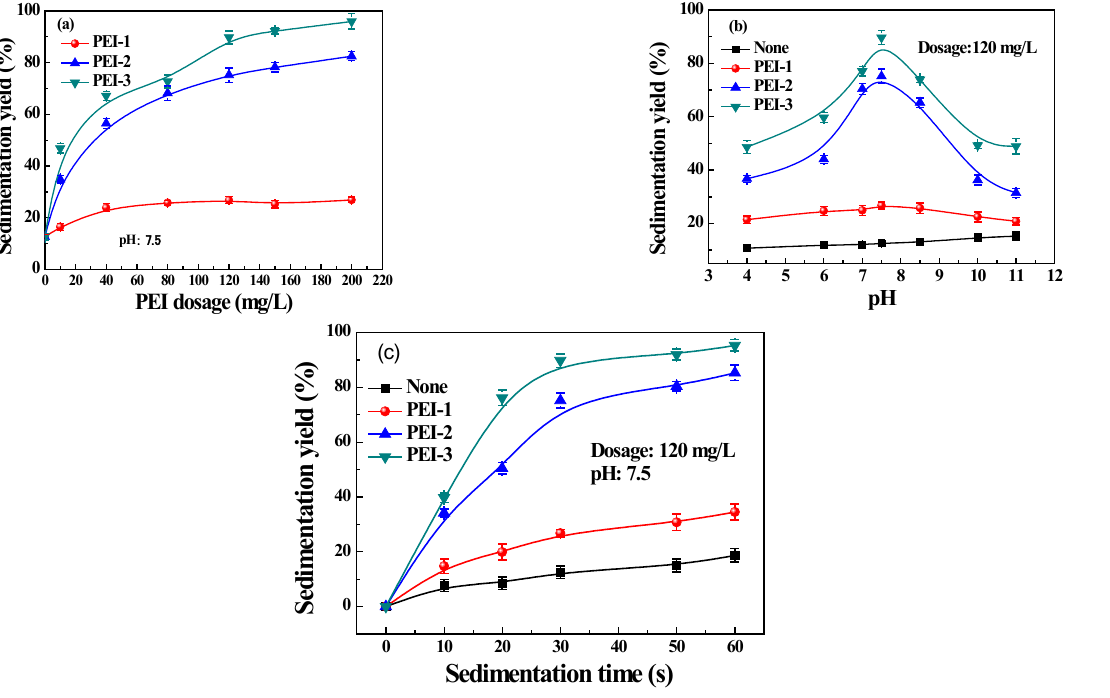
Figure 4. Effects of PEI dosage (pH = 7.5; sedimentation time 30 s) ( a ), pH (dosage, 120 mg/L; sedimentation time 30 s) ( b ) and sedimentation time (pH = 7.5; dosage, 120 mg/L) ( c ) on sedimen- tation yield.